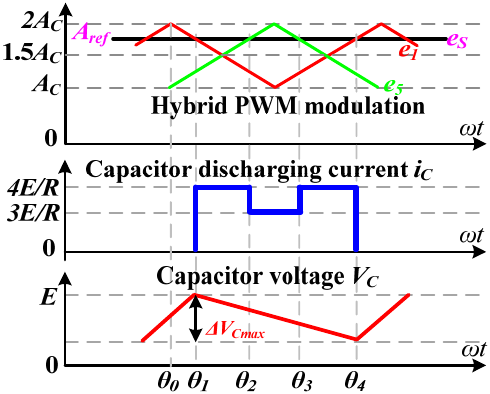
Figure 7. The maximum capacitor voltage ripple.